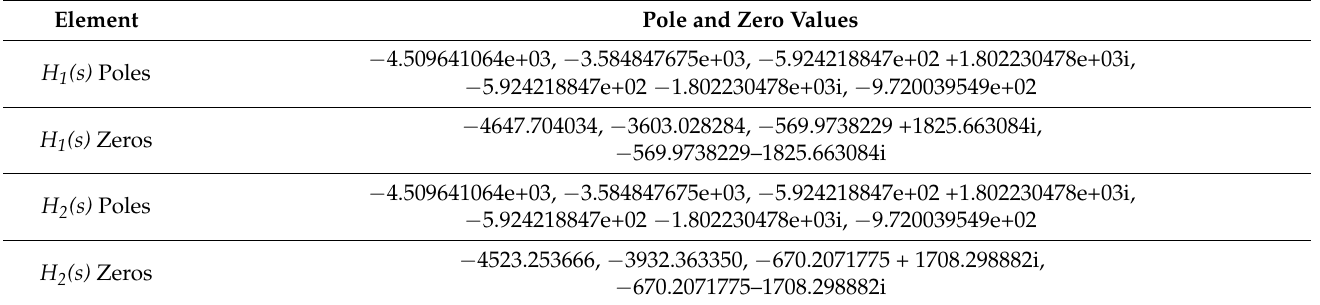
Table 3. The poles and zeroes of H 1 (s) and H 2 (s)